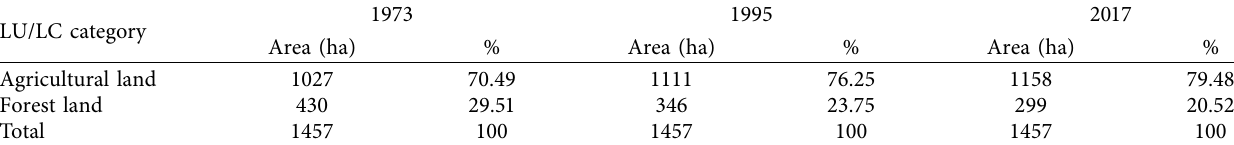
Table 4: Areas and percentages of LU/LC classes for the years 1973, 1995, and 2017.